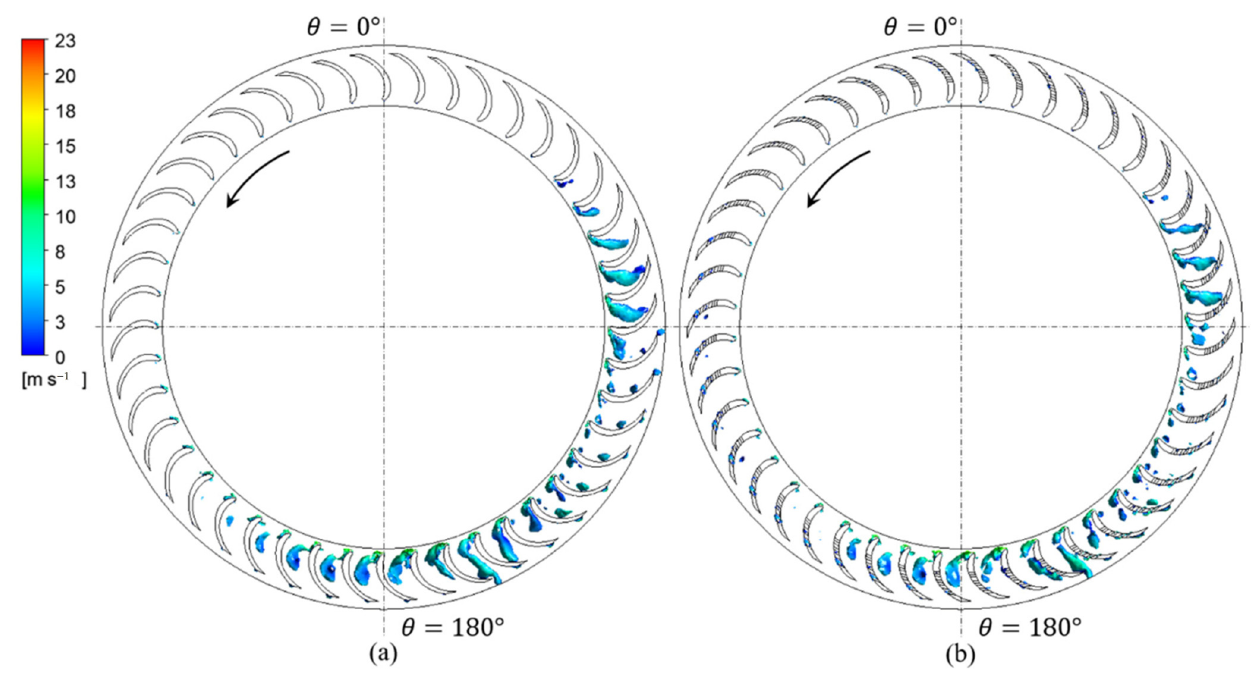
Figure 18. Vorticity distributions in the impellers ( a ) Original fan; ( b ) The fan with TBG. In order to study the noise reduction characteristics of the blade tip bionic groove, 12 noise monitoring points were evenly arranged every 30 degrees along the circumference of the section P top , as shown in Figure 19. Figure 20 shows the results of aerodynamic noise at the monitoring points of the original fan and the multi-blade centrifugal fan with TBGs. The noise of the multi-blade centrifugal fan with TBGs was reduced at all monitoring points, especially when the rotation angle 𝜃 equaled 150°~270° , where the reduction in aerodynamic noise reached its maximum. The main component of noise in this range is vortex noise, and a reduction in vortex intensity leads to noise reduction. In this range, the degree of flow separation at the impeller tip was effectively reduced by TBGs, and hence the vortex noise was also reduced. When 𝜃 = 0°~60° , the SPL reduction at the volute tongue was less than that at other monitoring points. The dynamic and static interaction between the impeller and the volute tongue is the main causative agent of noise at the volute tongue. However, TBGs mainly contributed to reducing the leakage flow at the impeller tip, thus reducing the vortex noise of the impeller; therefore, the SPL reduction at the volute tongue was small. Through the above analysis, the aerodynamic noise generated by the fan with TBGs was lower than that of the original fan. Thus, it is feasible to reduce the noise of multi-blade centrifugal fans by using triangular blade tip bionic grooves.